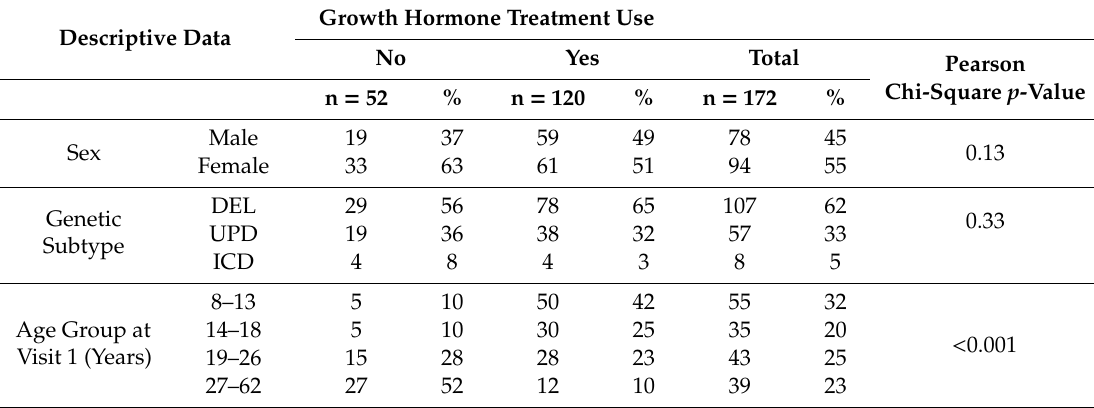
Table 5. Descriptive data by growth hormone treatment